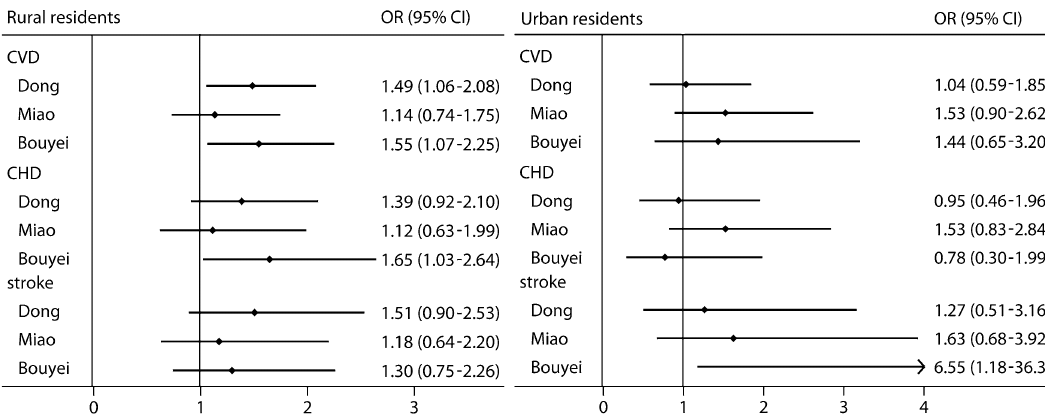
Figure 2. Risk of cardiovascular disease, coronary heart disease, and stroke in rural and urban areas. Adjusted for sex, age, educational attainment, annual household income, tobacco smoking status, alcohol drinking status, total physical activity, total energy intake, family history of cardiovascular disease, body mass index, and systolic blood pressure, fasting plasma glucose, and triglycerides levels. CHD coronary heart disease; CI confidence interval; CVD cardiovascular disease; OR odds